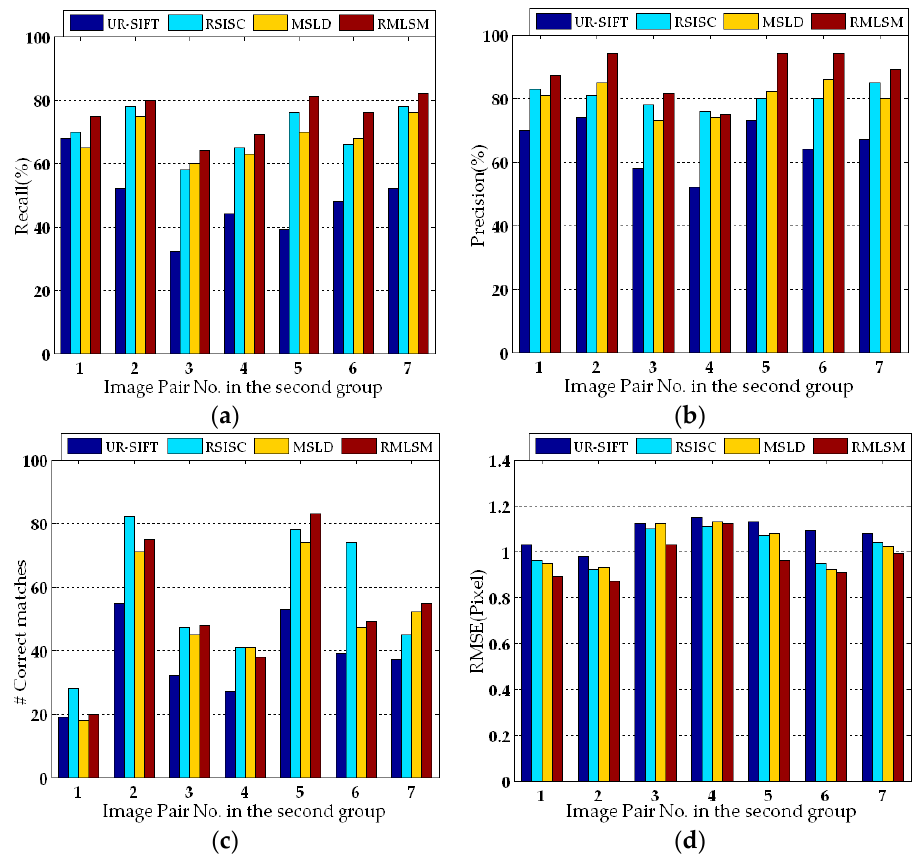
Figure 12. Experimental results on the real image pairs. ( a ) Recall; ( b ) precision; ( c ) correct matches; ( d ) RMSE.